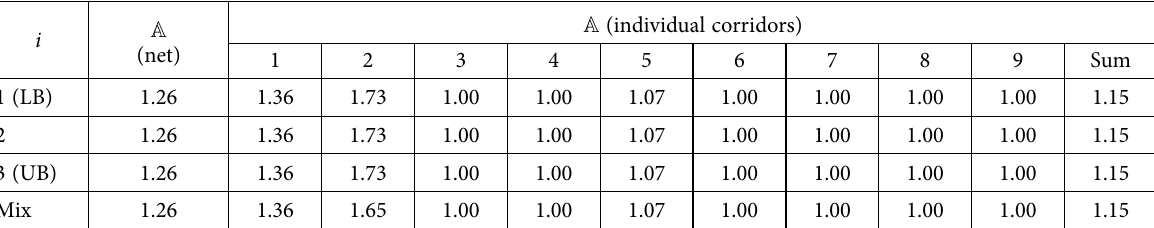
Table 9. Ratio of Table 3 to Table 7